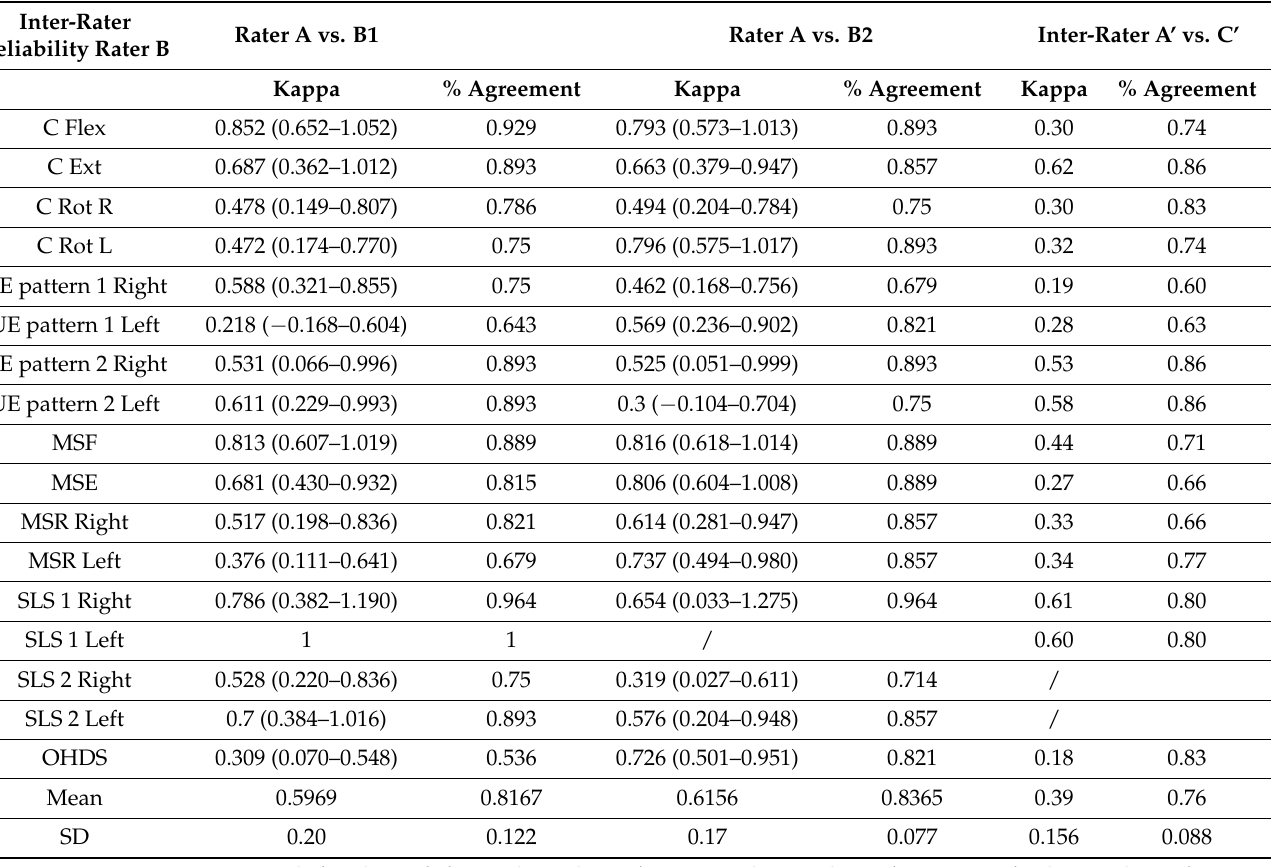
Table 3. Inter-rater reliability (evaluator A vs. B1 and A vs. B2). Inter-Rater